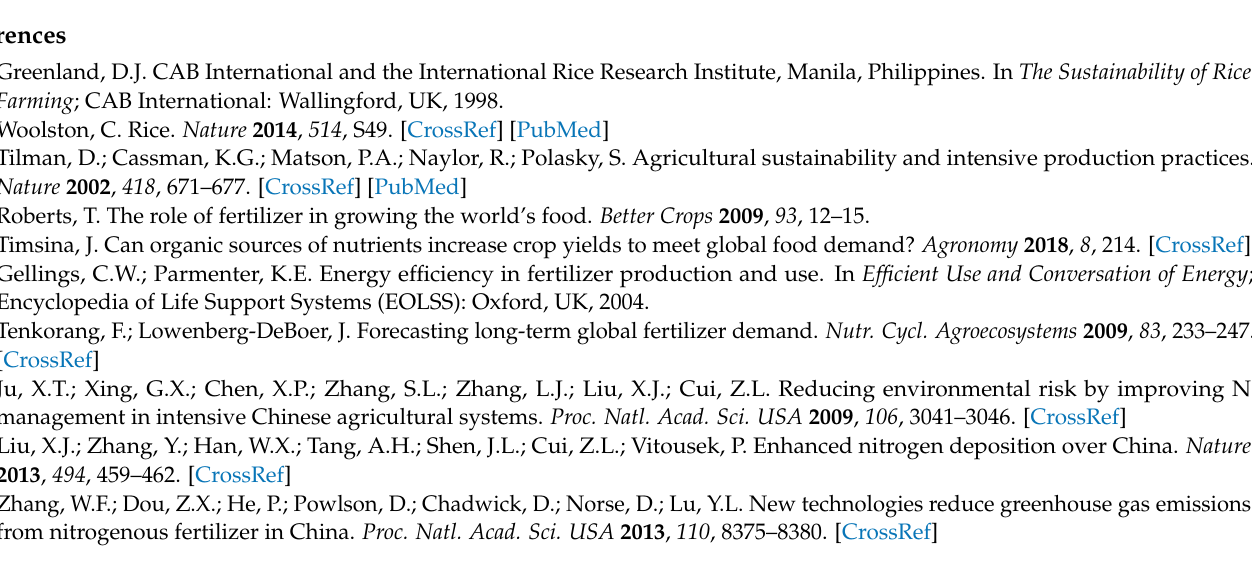
Figure S3: Ammonia concentration in field surface water under various nitrogen fertilization rates with or without iron amendment in 2019 (a) and 2020 (b), Figure S4: PH of field surface water under various nitrogen fertilization rates with or without iron amendment in 2019 (a) and 2020 (b), Figure S5: Soil moisture and temperature in the experimental field in 2019 (a) and 2020